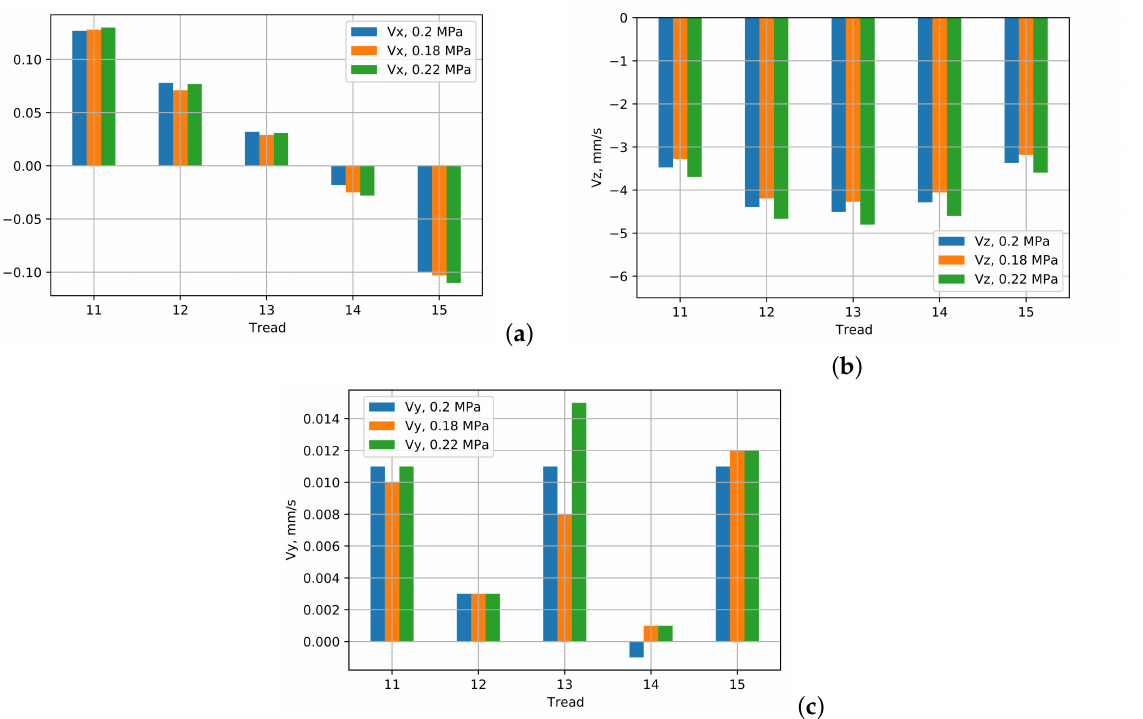
Figure 6. ( a ) Velocities of tread geometric centres in the x directions, ( b ) Velocities of tread geometric centres in the z directions, ( c ) Velocities of tread geometric centres in the y directions.